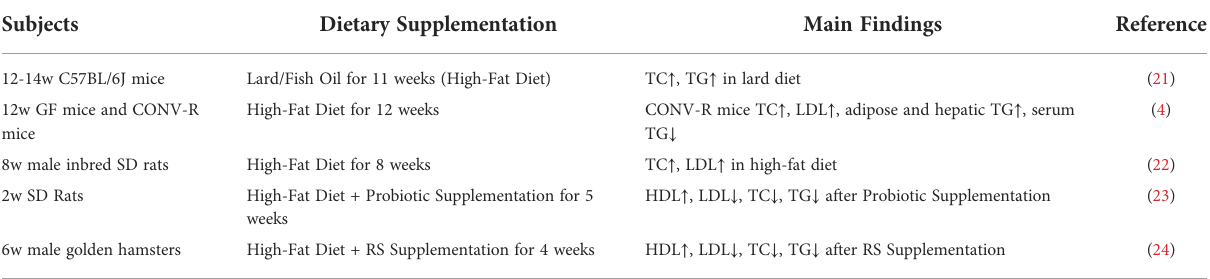
TABLE 1 Examples of recent association studies between lipid-related traits and the gut microbiota in murine